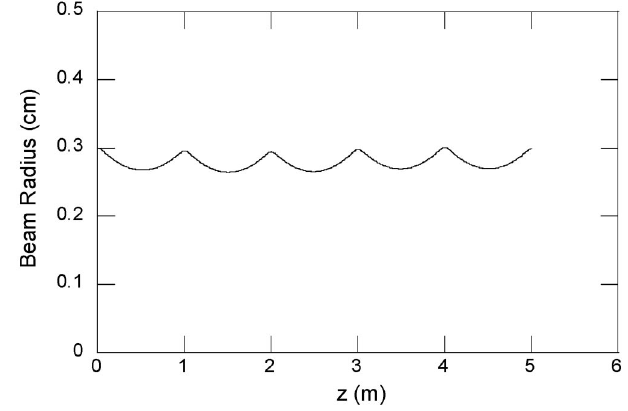
FIG. 17. Beam edge radius versus transport distance, for the period focusing case. 10-cm long solenoids are located at meter intervals, with strengths of 0.41